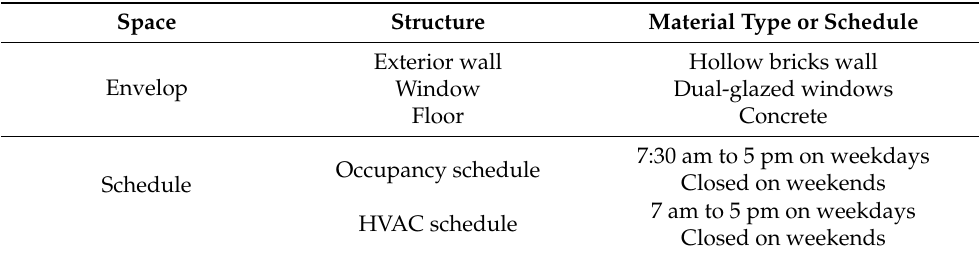
Table 1. Building properties of the test